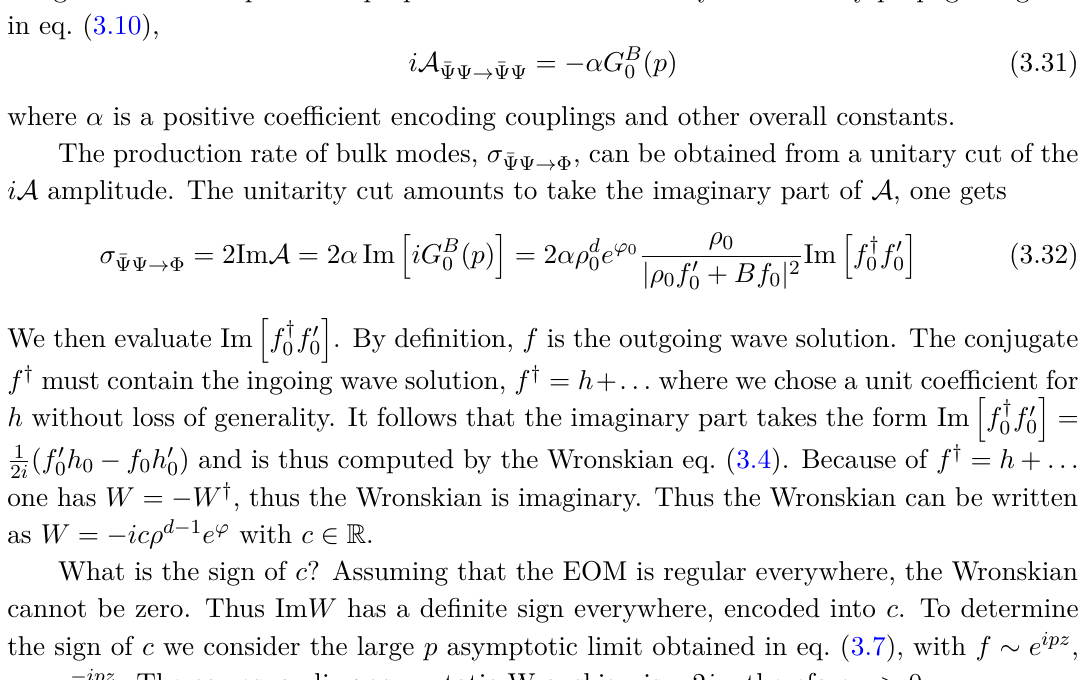
Figure 2 . The i A ¯ΨΨ